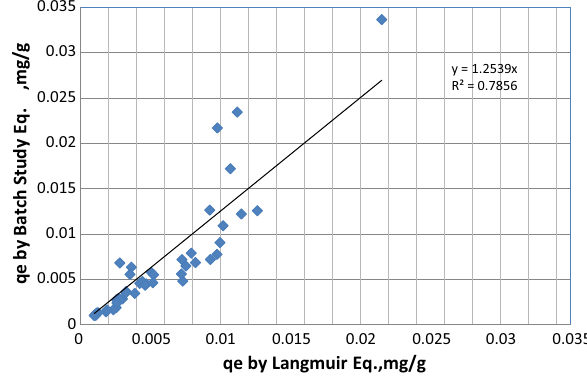
Fig. 8 Amount of heavy metal removal from solution by Langmuir equation and batch study equation